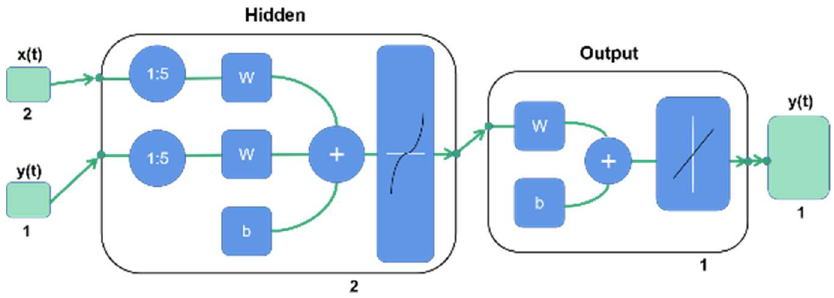
Figure 6. The open-loop structure of the NARX network with external input y(t).